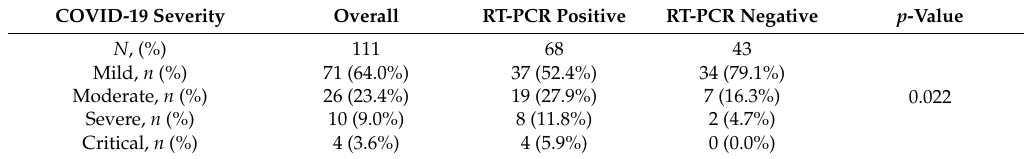
Table 2. COVID-19 severity in the overall sample and in terms of the SARS-CoV-2 RT-PCR results. COVID-19 Severity Overall RT-PCR